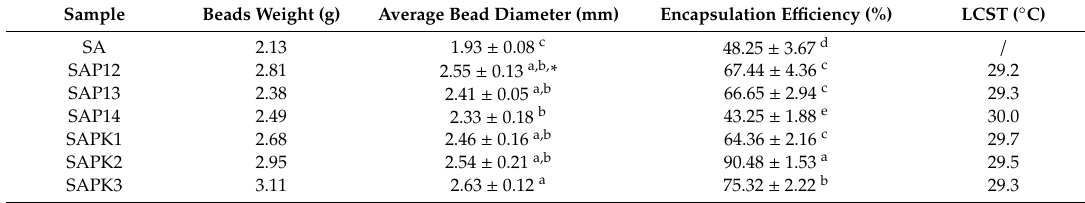
Table 2. Characteristics of the hydrogel